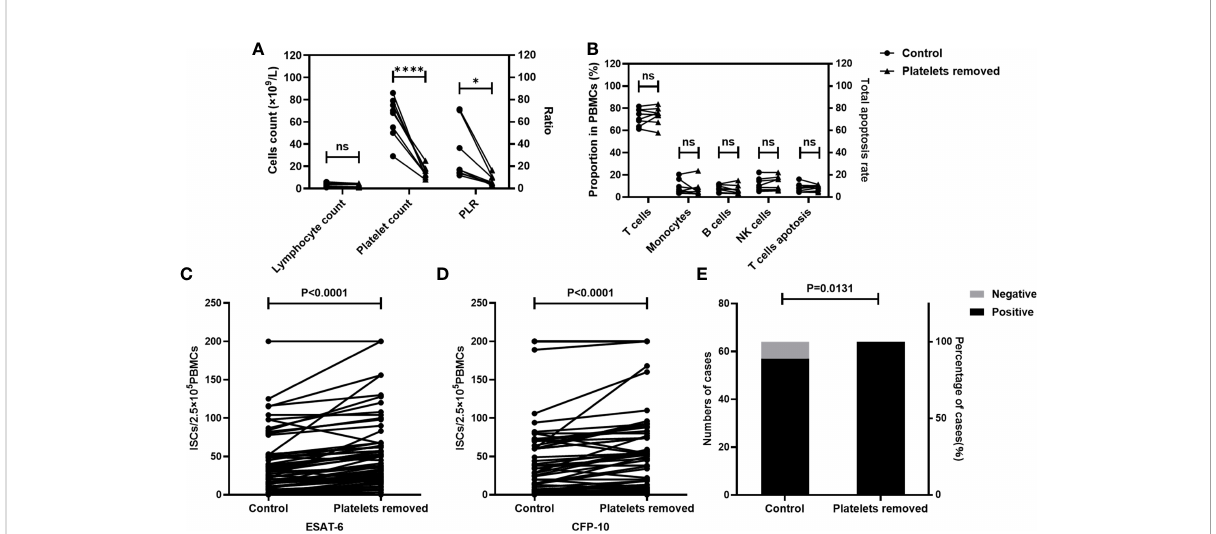
FIGURE 3 The numbers of ISCs and the positive results of T-SPOT were increased after the removal of platelets. The platelet count, the apoptosis rate of T cells, and the proportion of cells in non-platelet-removed PBMC sand platelet-removed PBMCs were measured (n=8). T-SPOT assays were performed with the non-platelet-removed PBMCs and platelets-removed PBMCs with the same numbers of mononuclear cells(n=64). (A, B) The lymphocyte count, the platelet count, the PLR, the apoptosis rate of T cells, and the proportion of cells in PBMCs in two groups